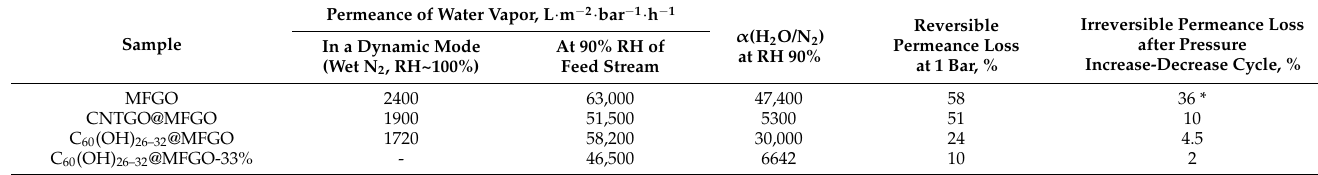
Table 2. Water vapor transport characteristics of composite membranes.